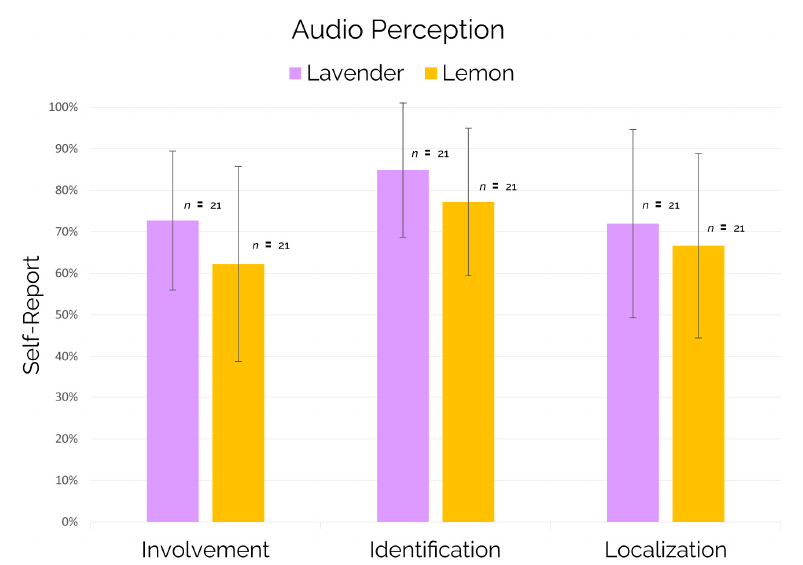
Figure 11. Self-reported measures of "audio involvement", "audio Identification", "audio localiza- tion" associated to the entire virtual reality experience and provided by subjects at the end of the experimental session.